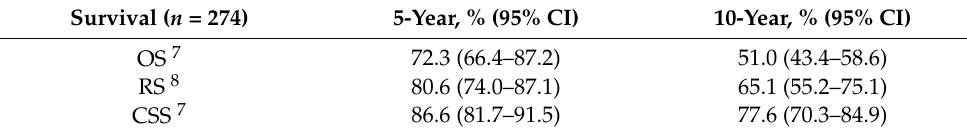
Table 5. Univariable analysis of overall survival, relative survival, and cancer specific